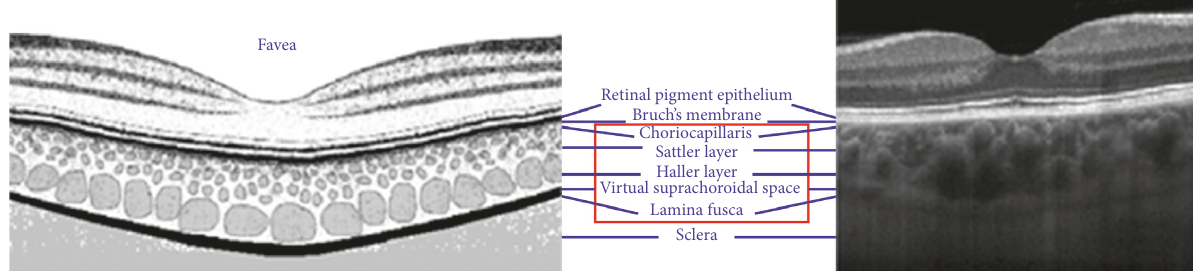
Figure 1: Choroid anatomy (histology and OCT). Choroid boundaries measured as the distance between the RPE/choroid interface and choroid/sclera interface. OCT: optical coherence tomography; RPE: retinal pigment epithelium. Table 1: The demographic features and baseline characteristics of